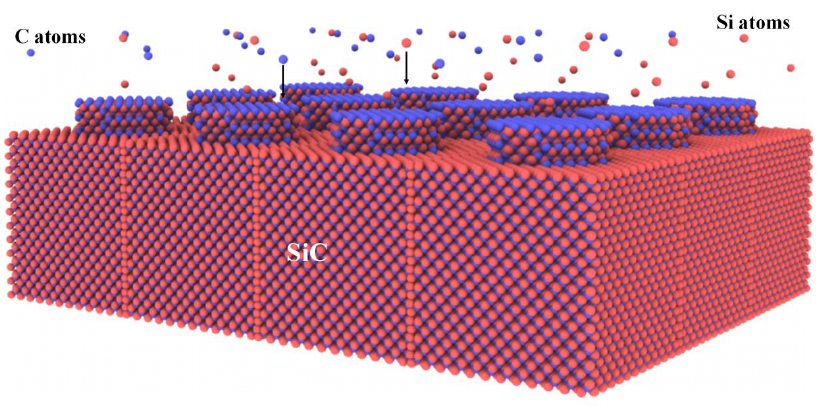
Figure 7. The typical deposition simulation model of SiC [70,71].